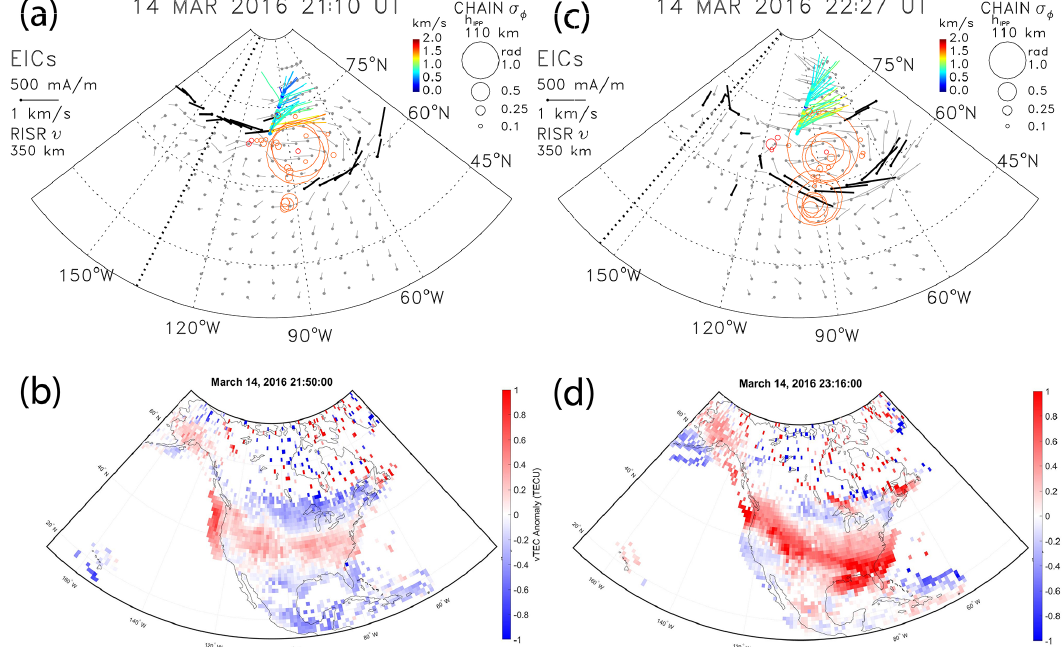
Figure 12. Panels (a, c) show the horizontal EICs with the latitudinal maxima highlighted in bold and the CHAIN GPS IPPs with enhanced phase-variation values, σ (cid:56) (scaled circles). Panels (b, d) show the detrended vTEC maps at later times on 14 March